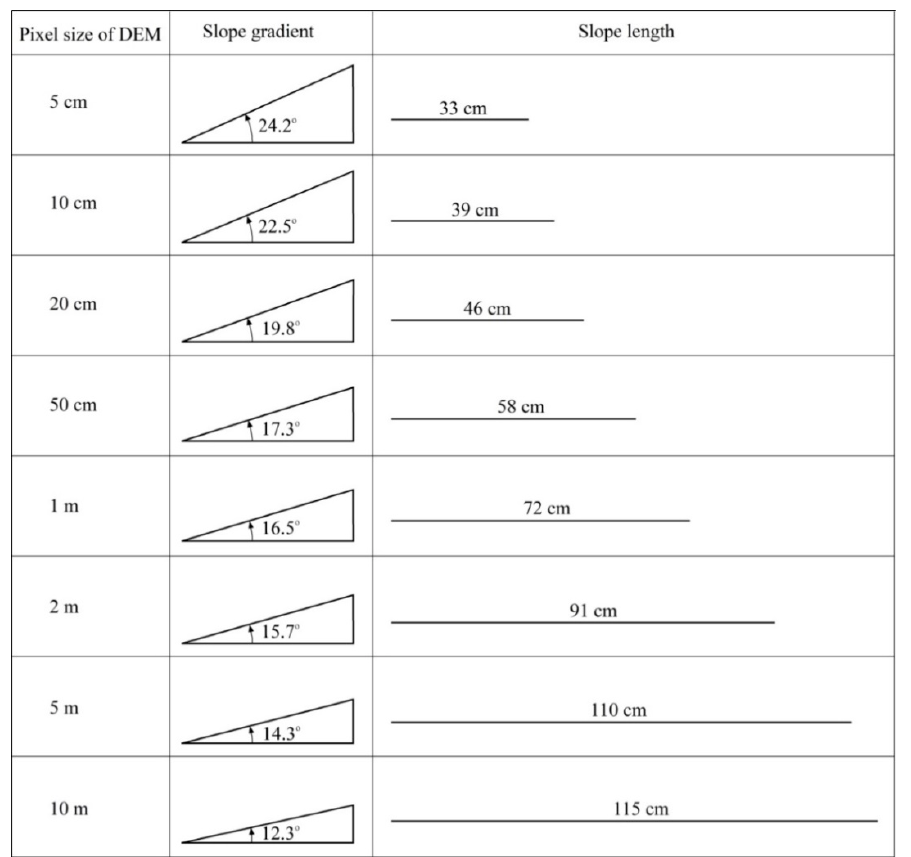
Figure 4. Derived average slope gradient and slope length by using DEM data with different pixel sizes.